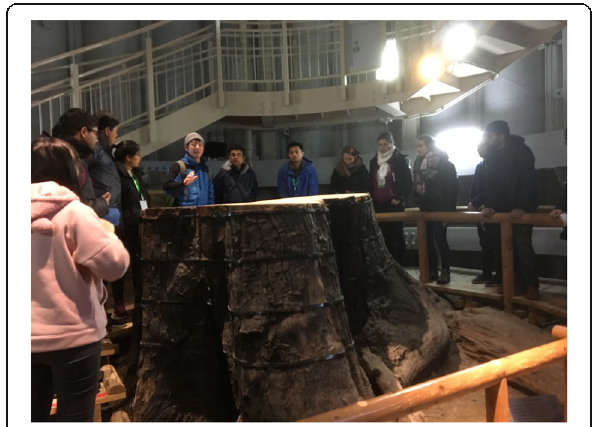
Fig. 4 Underground exhibition hall of The Sanbe-Azukihara Buried Forest